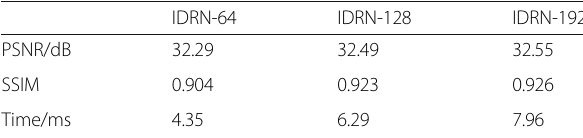
Table 2 The comparison for IDRN under different network width